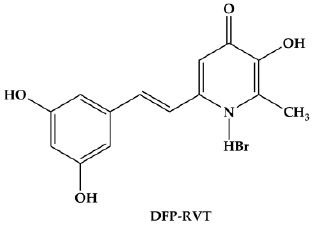
Figure 1. Chemical structure of the deferiprone-resveratrol hybrid (DFP-RVT) (redrawn from